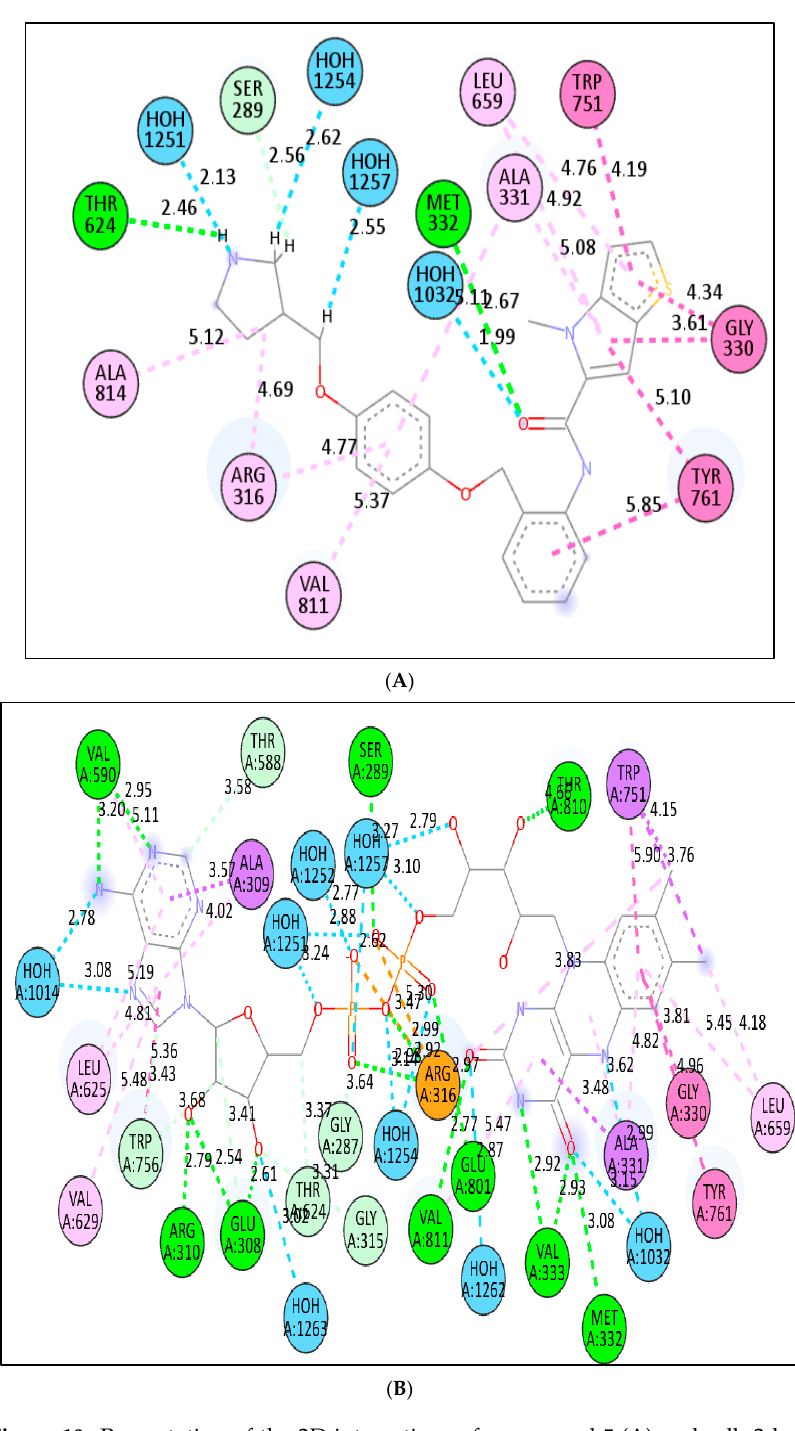
Figure 10. Presentation of the 2D interactions of compound 5 ( A ) and pdb-2dw4 ligand ( B ) with LSD1